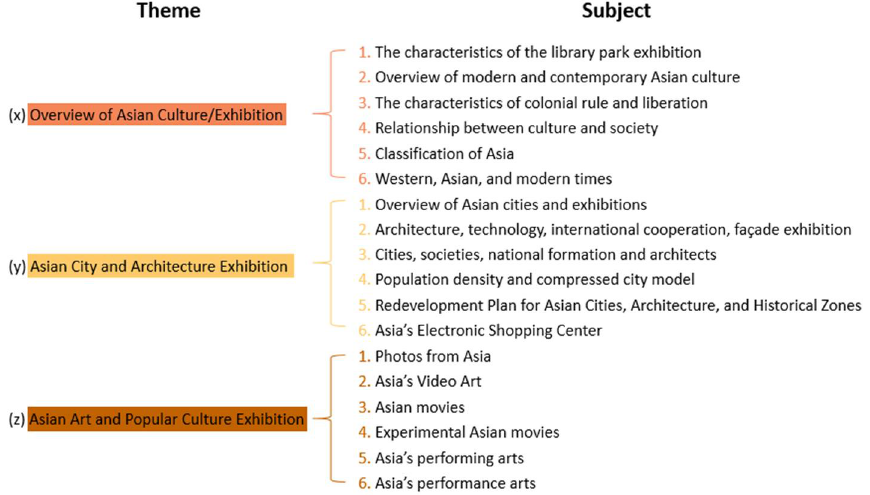
Figure 1. Data configuration: theme and subject.